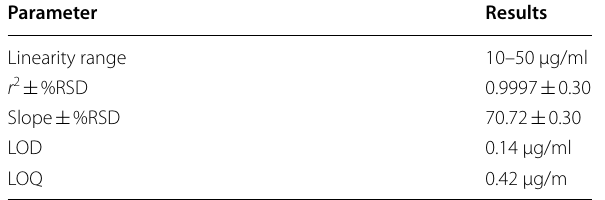
Table 13 Results of forced degradation studies ( n